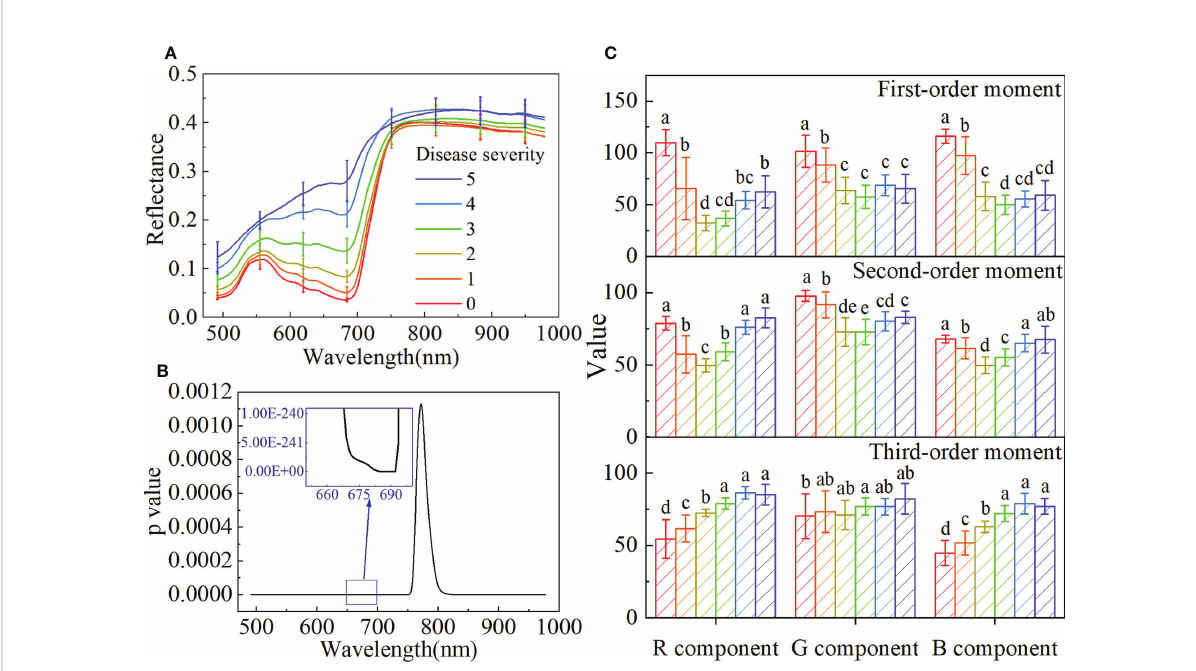
FIGURE 3 The spectral features and color features of the samples with different disease severity. (A) The average spectra with standard deviation. (B) The p value obtained by ANOVA for the spectra with different disease severity. (C) Bar charts with error bars of color features and different letters indicate signi fi cant differences between different disease severity using the Tukey method